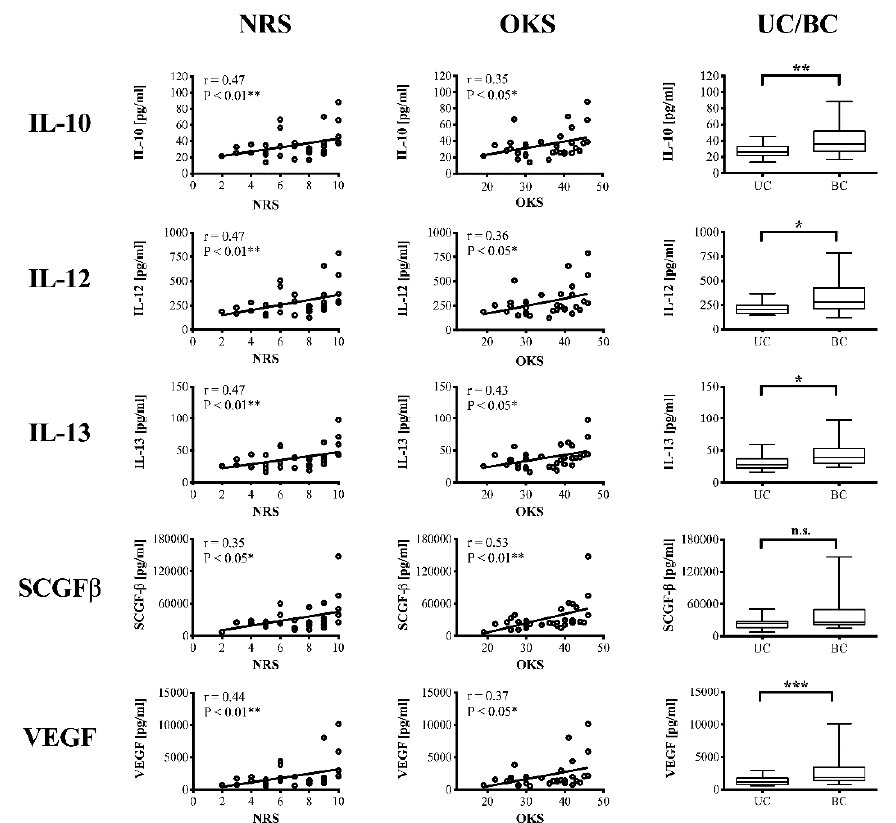
Figure 3. Significant correlations between inflammatory mediators and clinical parameters (NRS, OKS). Correlation analyses were performed using Spearman’s rank correlation coefficient (r). Since IL-10, IL-12, IL-13, SCGF β and VEGF did not show Gaussian distribution Mann–Whitney U test was performed to calculate differences in SF cytokine concentrations between unicompartmental (UC) and bicompartmental (BC) osteoarthritis. p -Values < 0.05 were considered statistically significant and are indicated with asterisks: * p < 0.05; ** p < 0.01. SF = synovial fluid; NRS = numerical rating scale; OKS = Oxford Knee Score; IL = interleukin; SCGF = stem cell growth factor; VEGF = vascular endothelial growth factor.